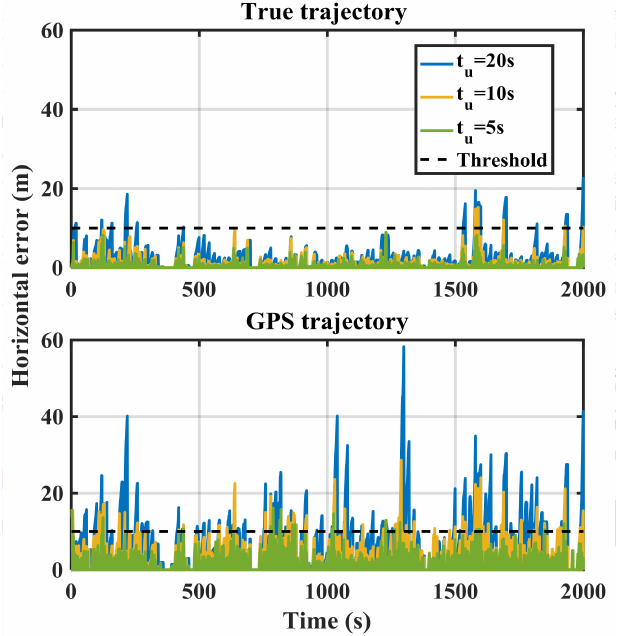
Figure 11. RIO (MEMS IMU) horizontal errors for various update intervals ( t u ) in the authentic case for true and GPS-based